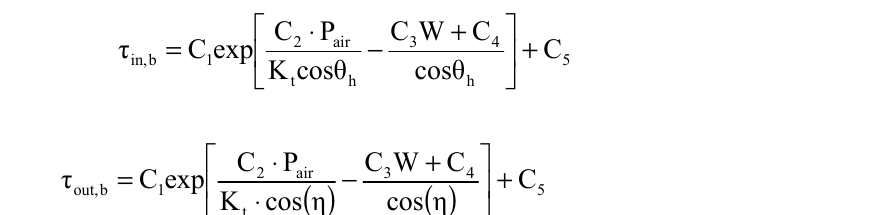
to C for Equations (5) and (6) and C 1 5